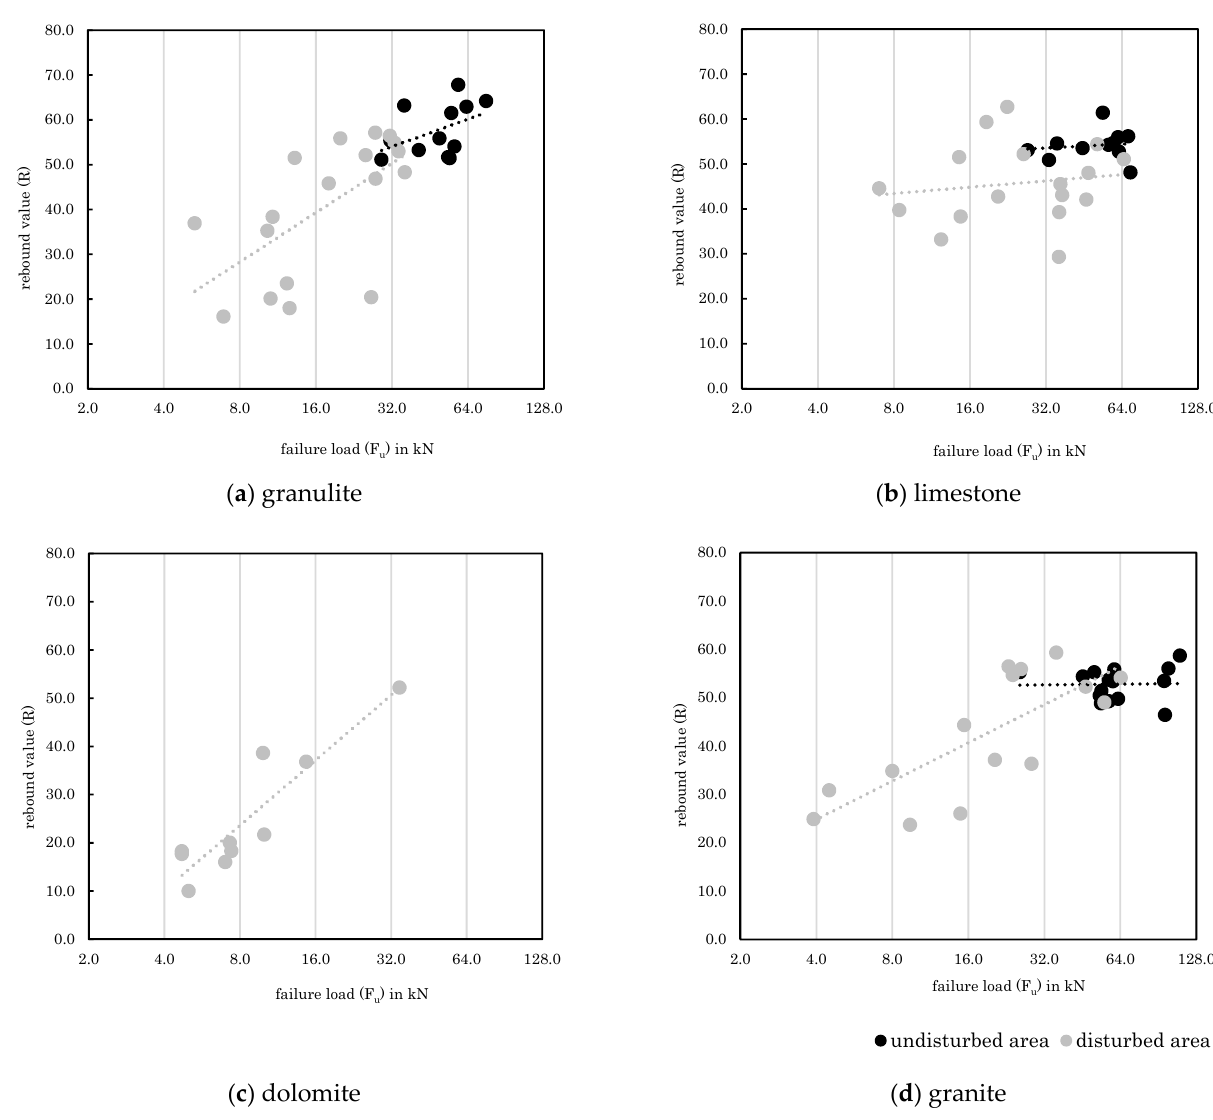
Figure 9. Relationships between rebound values and failure loads for various rock types. In Figure 10, all rock types are examined together. The rebound values (R) illustrated are equivalent to the mean rebound values from the anchor position. These are calculated out of eight values taken next to the anchor position (compare to Figure 2). Therefore, it is possible to indicate not only the mean rebound values, but also to plot the scattering per value (described by the coefficient of variation, CV). This form of presentation was chosen in Figure 10, where large data points indicate a high coefficient of variation. According to Figure 10, disturbed areas result in more scattering of rebound values than undisturbed areas. Inhomogeneities around the anchor position in disturbed areas thus lead to the varying rebound values. In undisturbed areas, intact rocks with more homogeneous proper ‐ ties lead to a more uniform distribution of rebound values, whereas low CVs should there ‐ fore indicate good rock properties.